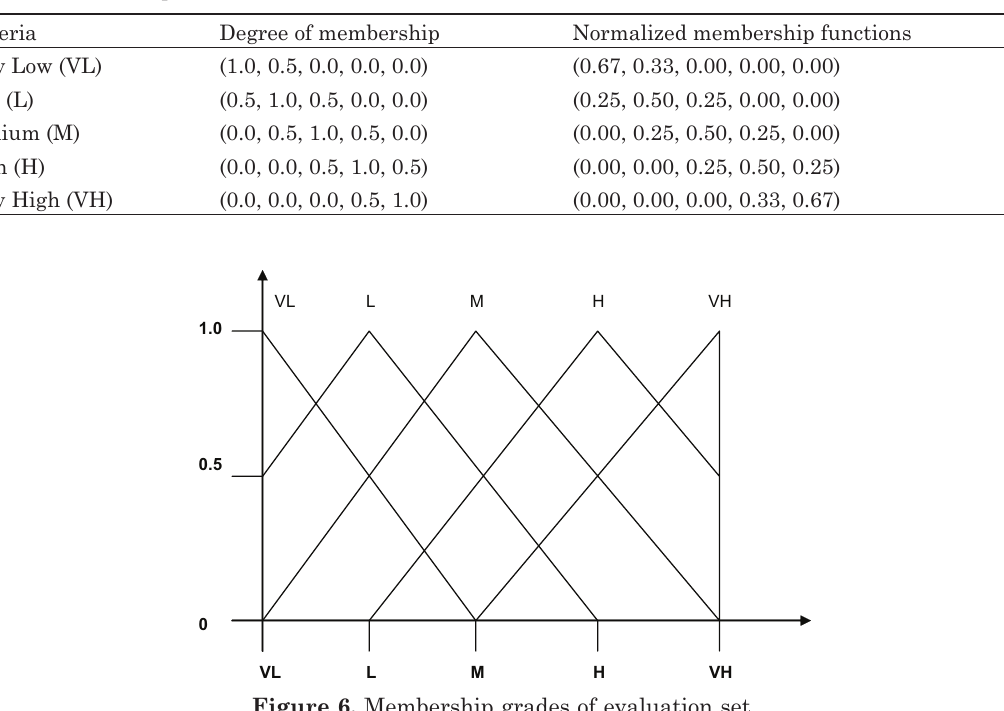
table 6. membership function for each